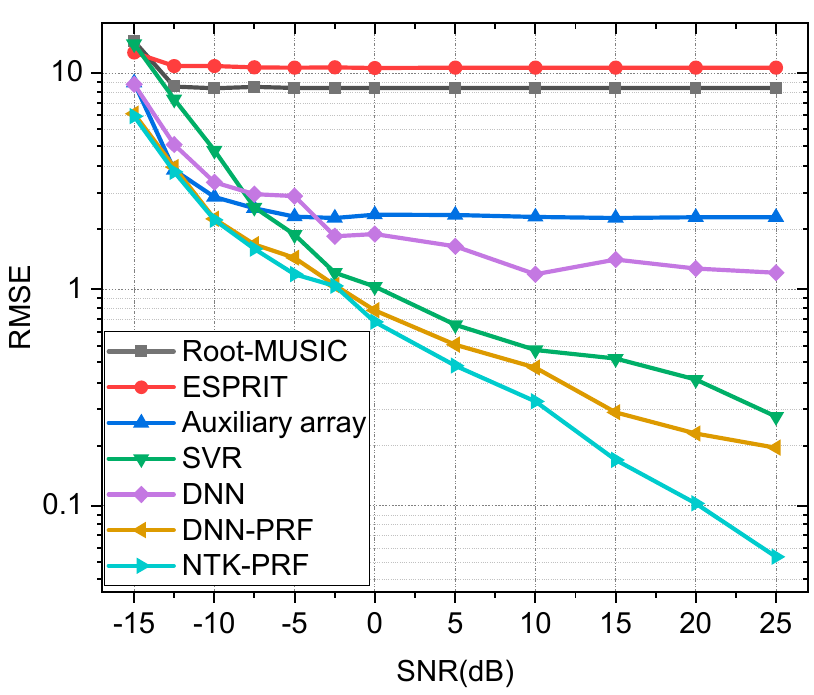
Figure 2. RMSE of a single signal DoA estimation with different methods vs. SNR for a 6-port dipole ULA Rx. Training data is at every 0.9° , and test data is at every 0.18° .